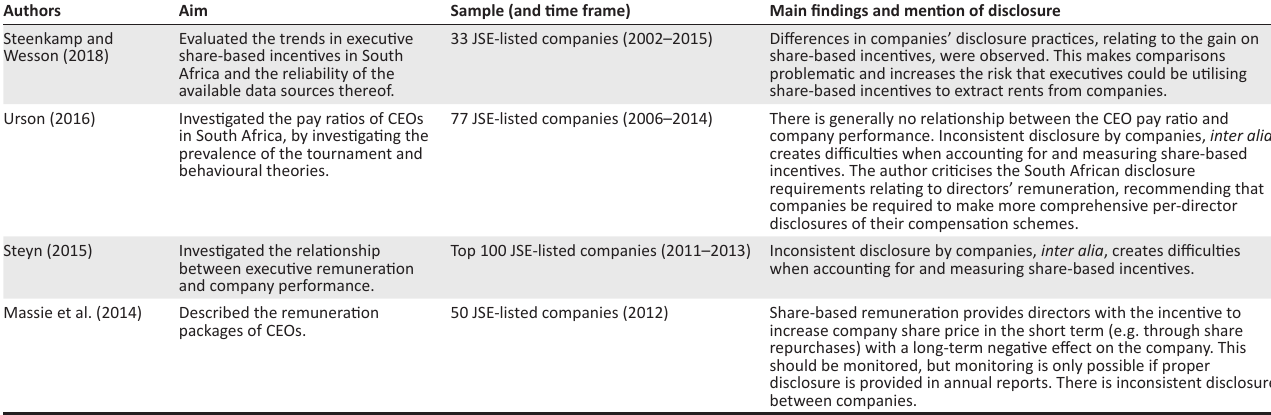
TABLE 1: South African studies on share-based